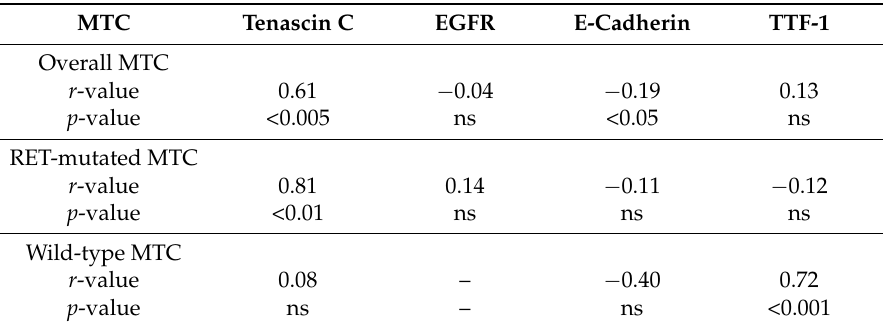
Table 1. Correlation of tenascin C, EGFR, E-cadherin, and TTF-1 expression with the proliferation marker Ki-67. MTC Tenascin C EGFR E-Cadherin TTF-1 Overall MTC